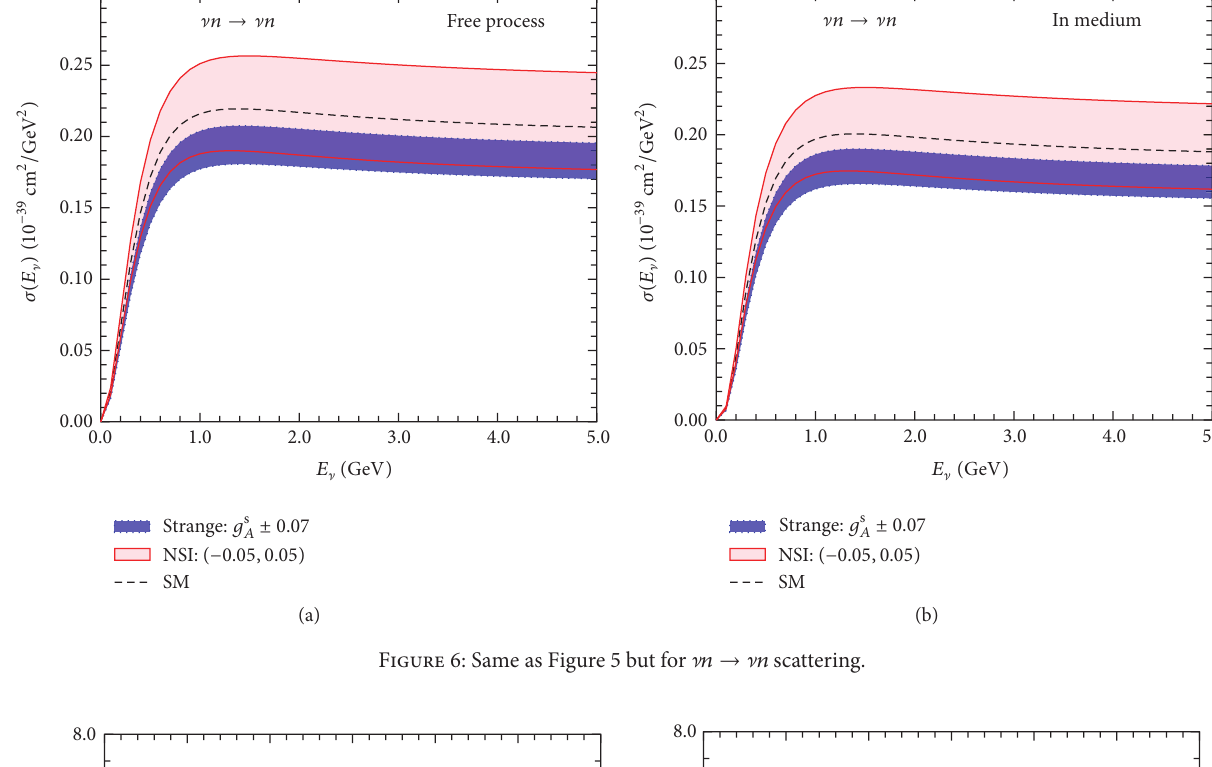
Figure 6: Same as Figure 5 but for ] 𝑛 → ] 𝑛 scattering.